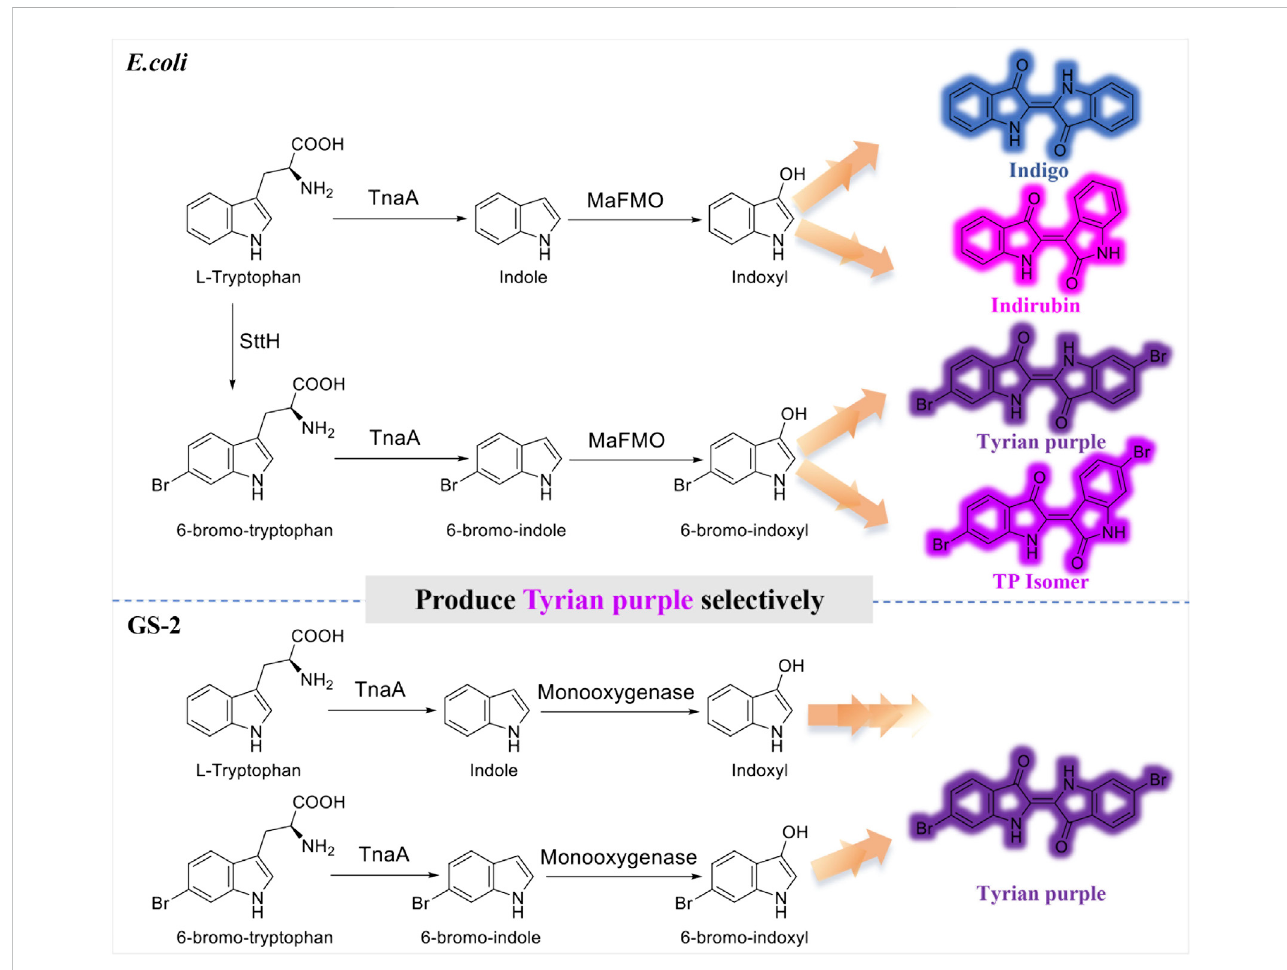
FIGURE 1 Productionofindigo,indirubin,Tyrianpurple,andTPisomerfromtryptophanor6-bromo-tryptophan: E.coli ,expressingtryptophan6-halogenaseSttH, and fl avin-containing monooxygenase MaFMO from Methylophaga aminisul fi divorans in E. coli . GS-2 , in the bacterial strain